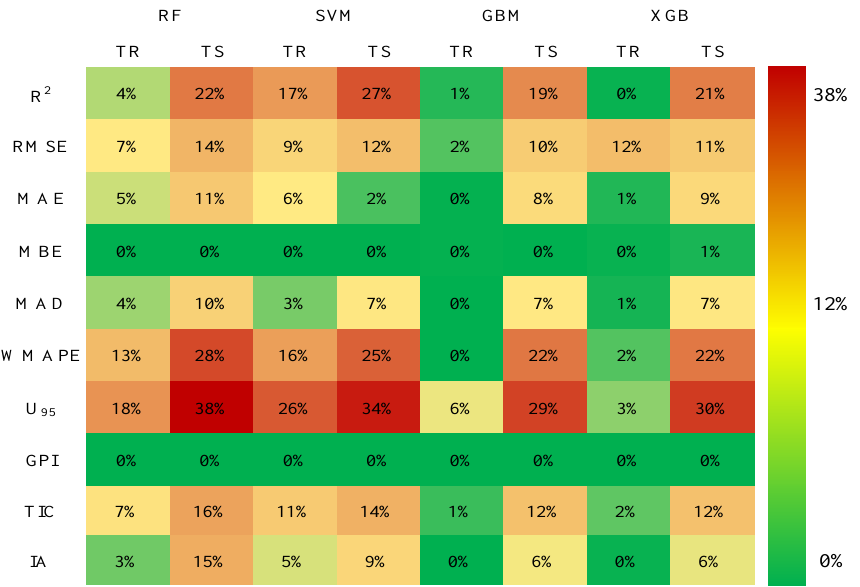
Figure 14. Taylor’s plot for ML model testing datasets. 6 . 5 . Reliability Analysis Figure 15 shows the comparison of the reliability index values for the actual and pre- dicted models for the testing dataset, separately. For the computation of the reliability index, the first-order reliability method ( FORM ) is used. It is observed that the reliability index values for the proposed model are close to the actual value. Therefore, the GBM model is reliable for use in designing the energy pile.